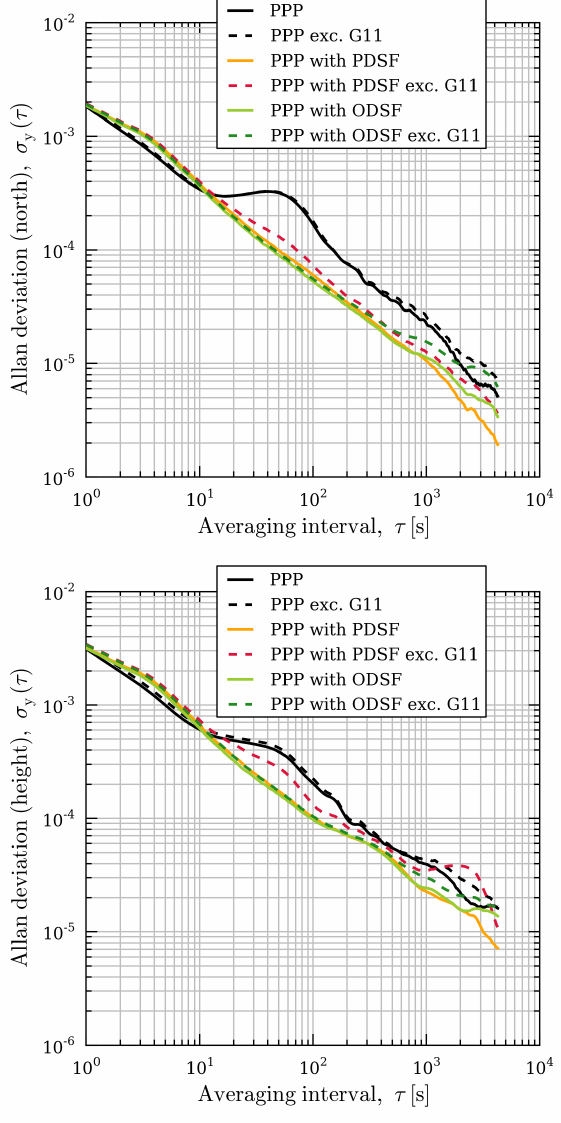
Figure 11: Allan deviation plots of the corresponding northing (top) and height (bottom) position time series at station UEL between 15:17 and 21:04 on August 31 2013 shown in Fig. 10.